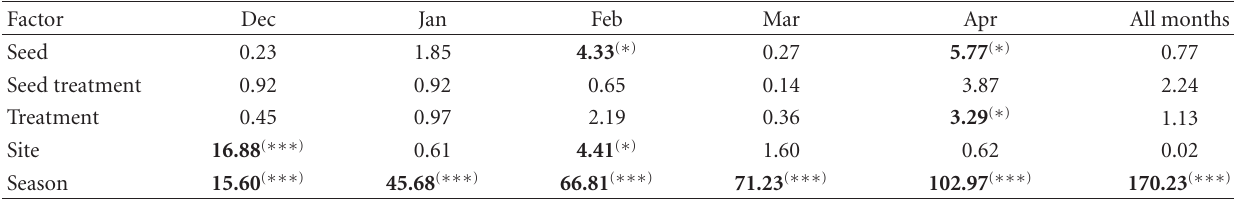
Table 1: F values from nonparametric analysis of ranked canola plant weight (grams).